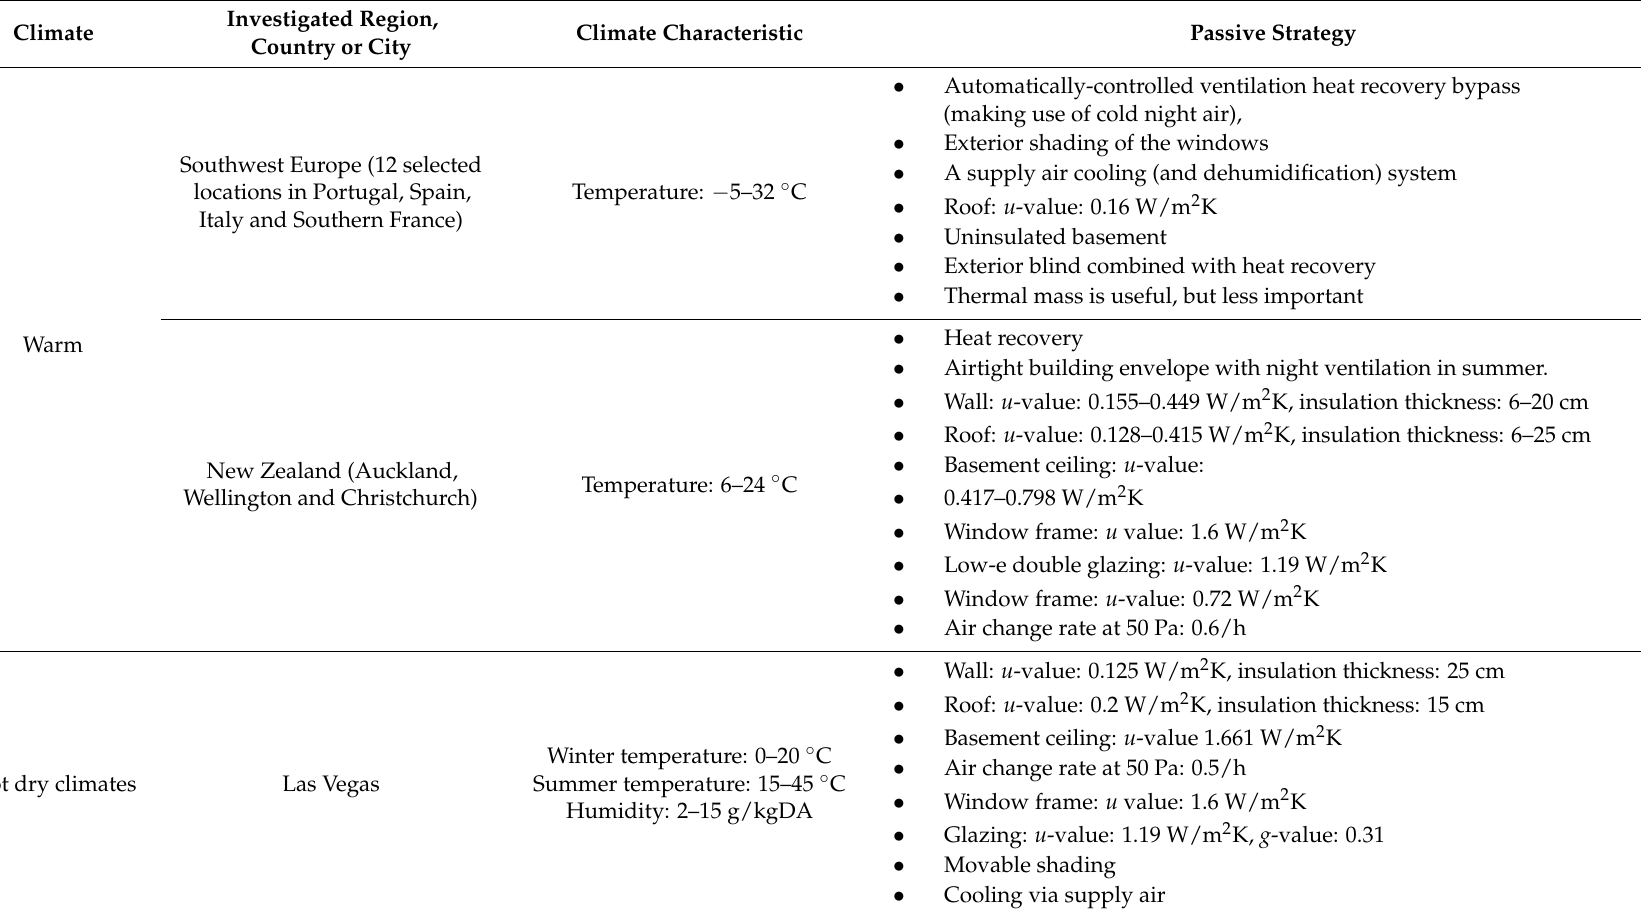
Table 2. Passive house strategy in warm